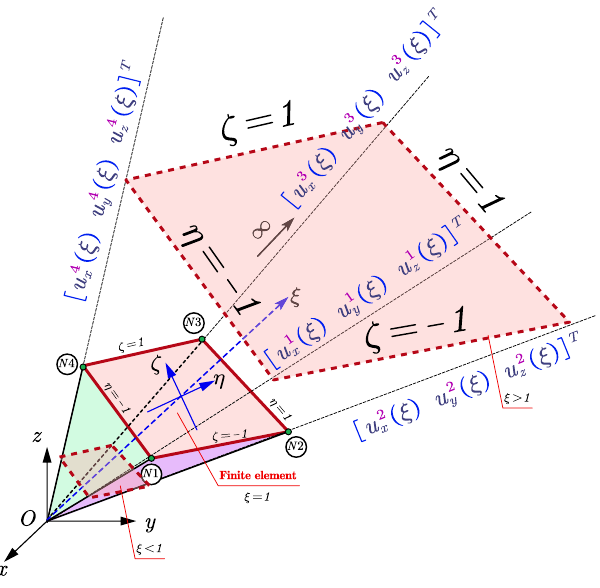
Figure 5. Displacement field discretization of the